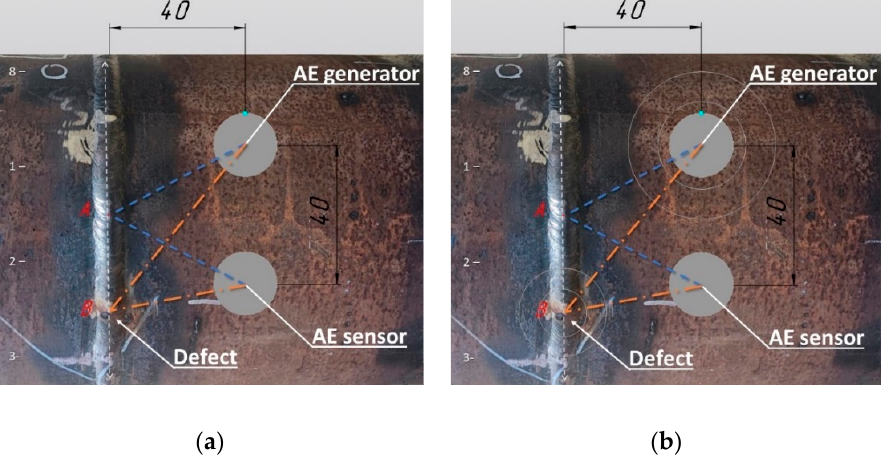
Figure 5. Positioning of the AE sensors on the surface of the pipe near the weld seam: ( a ) geometric parameters; ( b ) AE waves spread from the AE generator to the AE sensor.